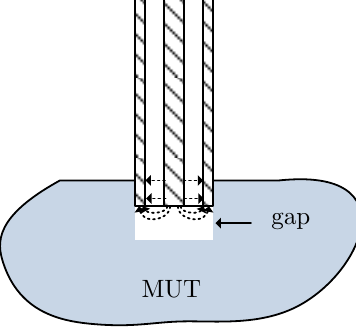
Figure 11. Accidental gap between the coaxial probe tip and the phantom